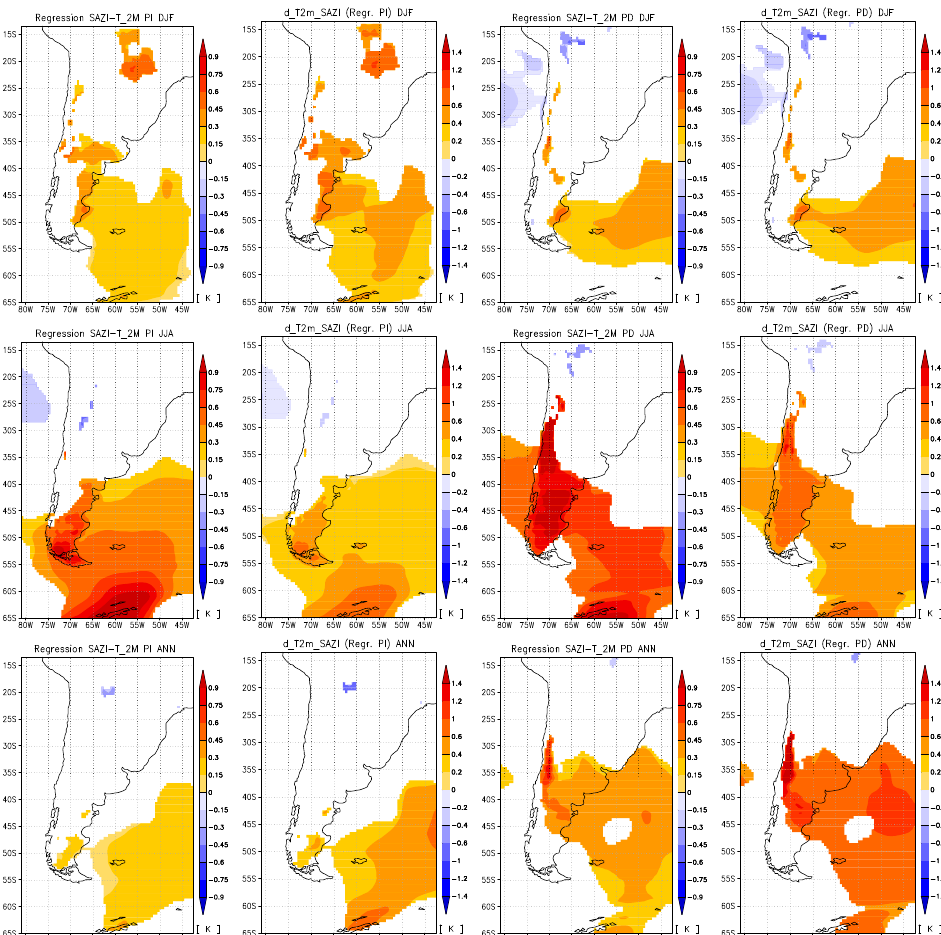
Fig. 8. Regression maps between SAZI and near-surface temperatures (1st and 3rd column) and temperature changes caused by SAZI differences between PD and PI (2nd and 4th column). Columns 1 and 2: regression based on pre-industrial period; columns 3 and 4: regression based on present-day period. Upper row: DJF; middle row: JJA; lower row: annual. Only statistically significant regression coefficients and related SAZI differences at the 5% level are displayed.53